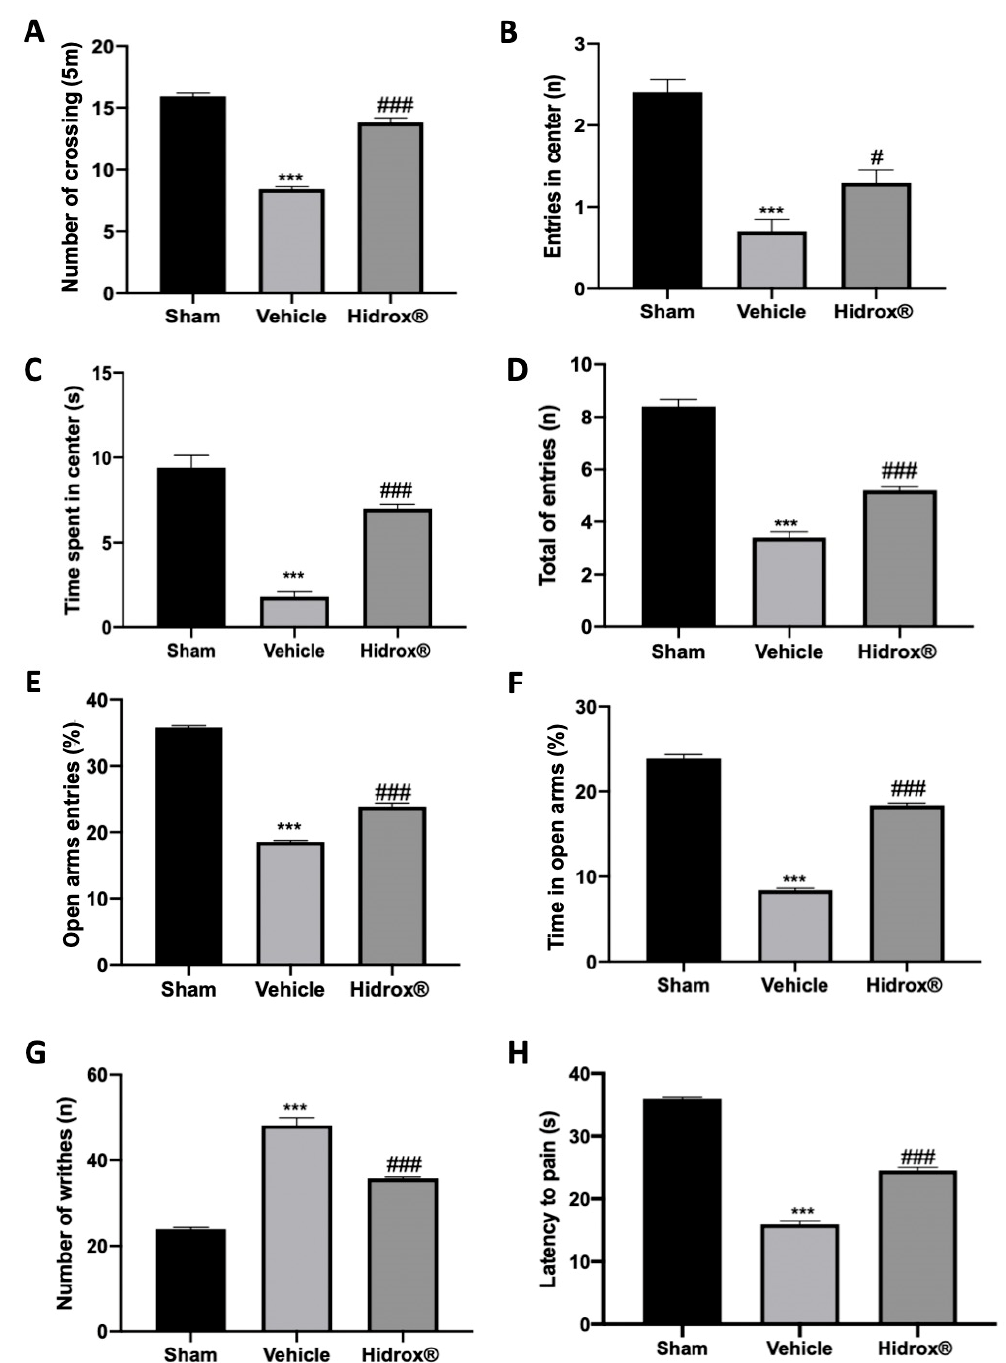
Figure 6. Hidrox ® administration reduced behavioral alterations endometriosis-induced: open field test: number of crossings ( A ), number of entries in central square ( B ), and time spent in central square ( C ); elevated plus maze test: number of entries in closed and open arms ( D ), % of open entries ( E ), % of time in open arms ( F ), acetic-acid-induced abdominal contractions ( G ), hot plate test ( H ). For the analyses, n = 5 animals from each group were employed. A p -value of less than 0.05 was considered significant. # p < 0.05 vs. vehicle, *** p < 0.001 vs. sham, ### p < 0.001 vs. vehicle.